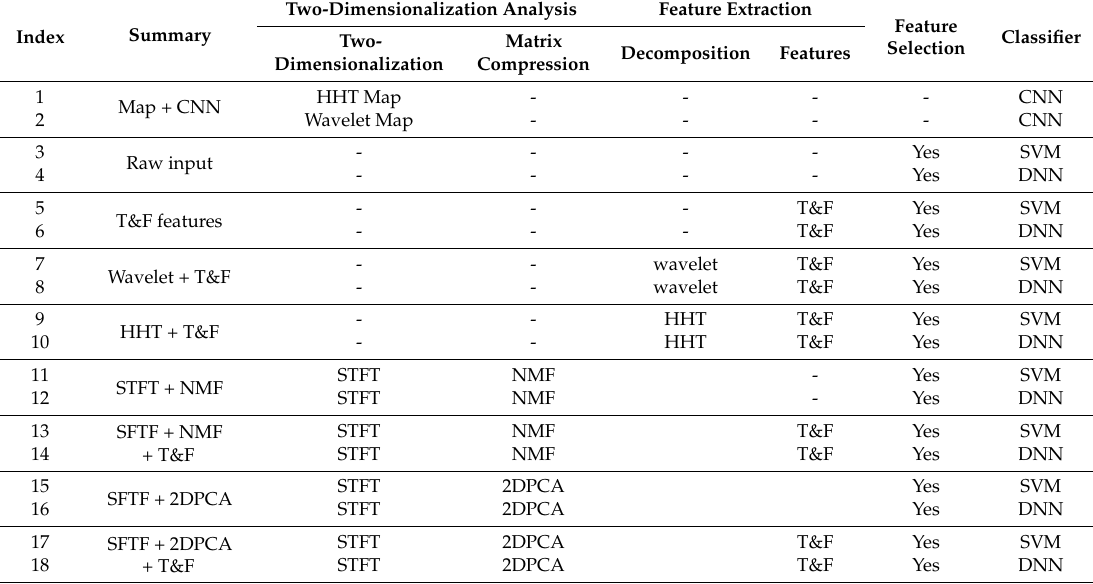
Table 5. Typical diagnosis models for comparisons.